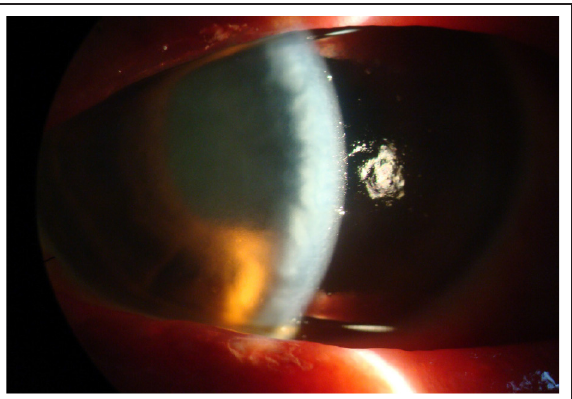
Figure 2. Corneal oedema with shallow anterior cham- ber in left eye.